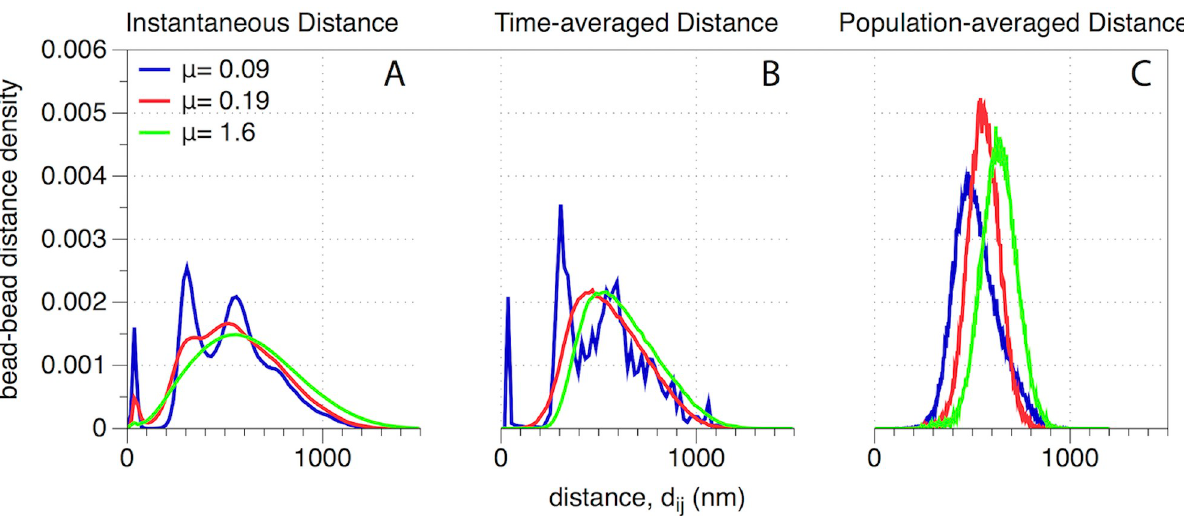
Fig 5. (A) Instantaneous distances, (B) time-average distances, and (C) population-averaged distances. In each panel, we show results for the three kinetic regimes illustrated in Fig 1: μ = 0.09, μ = 0.19, and μ = 1.6. As reported in [21], multimodal histograms are a “signal” for the presence of clusters. This signal is strongest for μ = 0.09, is nonexistent for μ = 1.6, and we observe a new regime for μ = 0.19 (flexible clustering or cluster plasticity), whereby ‘soft’ clusters form but deform over time through cluster